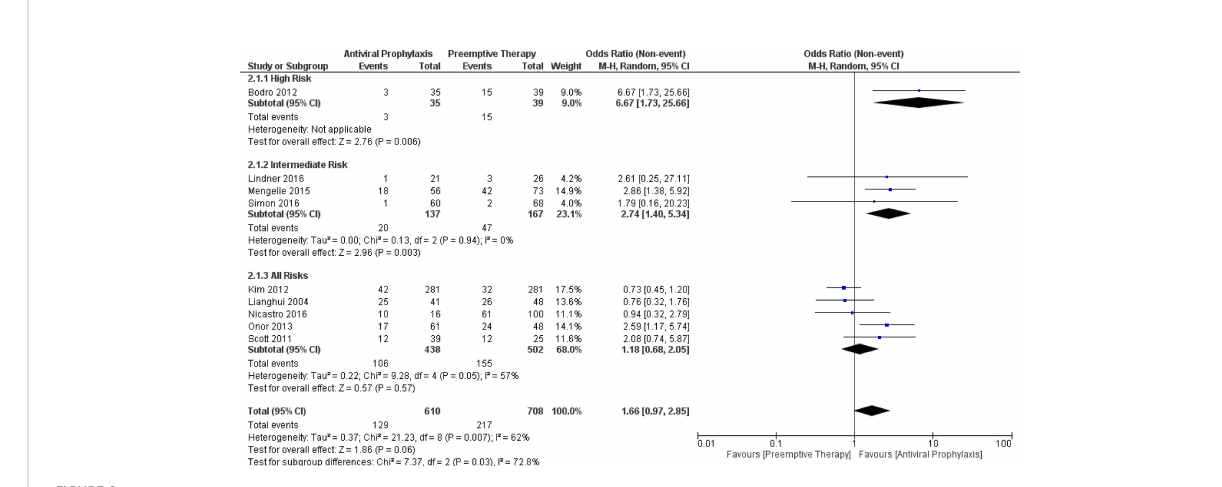
Incidence of leukopenia and neutropenia The pooled results revealed the incidence of leukopenia in the overall LT recipients and intermediate-risk group receiving antiviral prophylaxis and preemptive therapy were 30.5% vs. 25.5% (4 vs. 4 studies and 158 vs. 242 patients) and 20.9% vs. 18.5% (2 vs. 2 studies and 81 vs. 94 patients), respectively. (Supplementary Figure 7) Simultaneously, the incidence of neutropenia in the overall LT recipients and intermediate-risk group receiving antiviral prophylaxis and preemptive therapy were 5.8% vs. 6.8% (5 vs. 5 studies and 403 vs. 402 patients and 4% vs. 3.6% (2 vs. 2 studies and 81 vs. 94 patients), respectively (Supplementary Figure